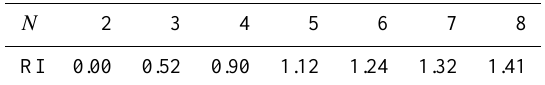
Table 9. Showing values of RI (Saaty and Vargas 1991), with n = order of the